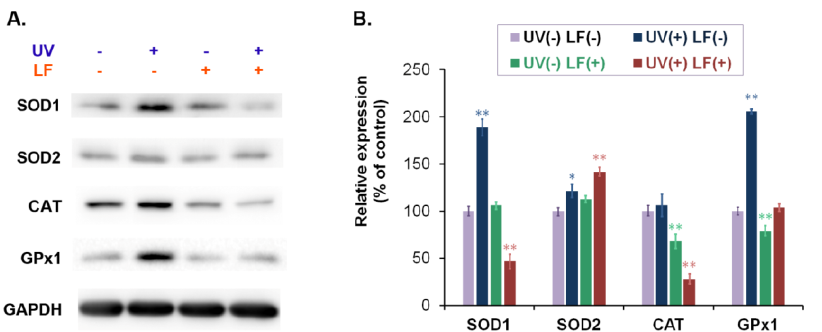
Figure 4. Lomefloxacin alone as well as with UVA radiation modifies the expression of antioxidant enzymes. Cells were exposed to lomefloxacin (LF) at a concentration of 0.5 mM and UVA radiation at a dose of 1.3 J/cm 2 . The levels of superoxide dismutase isoforms 1 and 2 (SOD1, SOD2), catalase (CAT) as well as glutathione peroxidase isoform 1 (GPx1) were examined by western blot analysis. The results are presented as ( A ) representative blot images and ( B ) bar graphs. * p < 0.05, ** p < 0.01 vs. control.